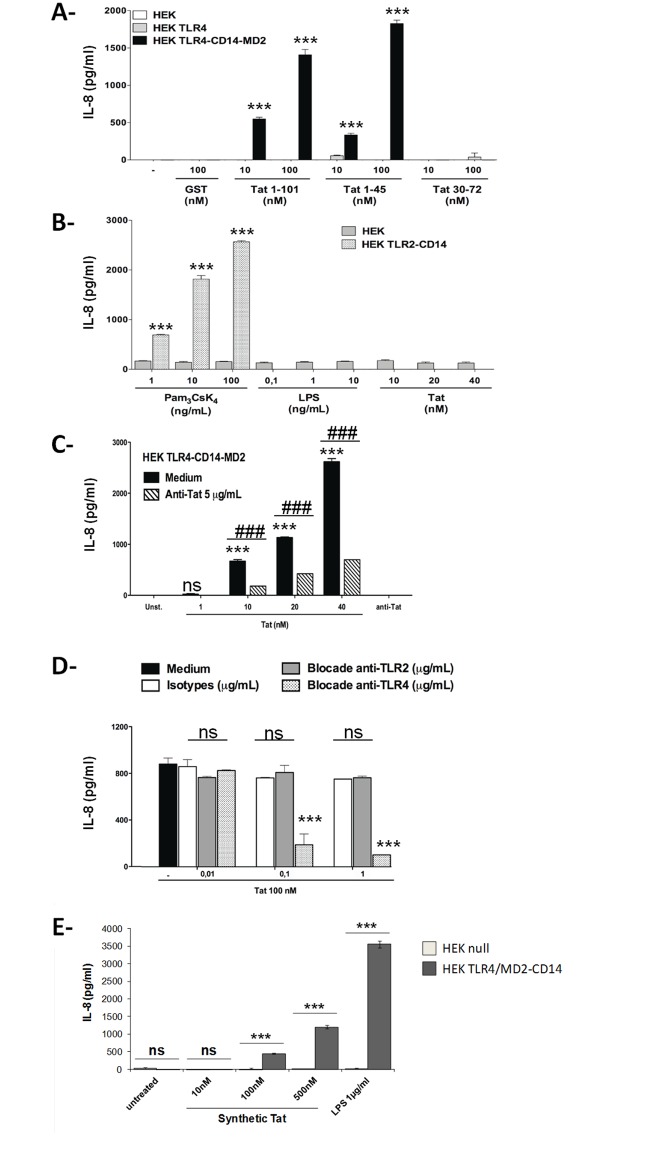
HIV-1 Tat induces production of IL-8 production in a TLR4-CD14-MD2 dependent manner.(A) HEK cell lines expressing TLR4 (grey histograms), TLR4-CD14-MD2 (black histograms), or HEK null, carrying an empty plasmid (white histograms) were pretreated or not with 10 and 100 nM of GST-Tat 1–101 or its deleted mutants 1–45 or 30–72. After 24 hrs., culture supernatants were recovered and IL-8 production was measured by ELISA. The data represent means +/- SD of three independent experiments. (B) HEK Null or HEK cell expressing TLR2-CD14 were pretreated or not with indicated amounts of GST-Tat 1–101 or LPS or Pam3CSK4. After 24h, IL-8 production in culture supernatant was analyzed by ELISA. The data represent means +/- SD of three independent experiments. (C) HEK-TLR4-CD14-MD2 cells were stimulated with Tat protein (Black histograms) or Tat protein previously incubated with 5 μg/mL of anti-Tat blocking antibodies (hatched histograms). After 24h of stimulation, IL-8 production induced by Tat was quantified in the culture supernatant by ELISA. The data represent means +/- SD of three independent experiments. (D) HEK-TLR4-CD14-MD2 cells were previously treated with increasing amounts of mAb anti-TLR4 or anti-TLR2 or isotypes control for 60 min before stimulation with Tat. After 24h, IL-8 production was measured in the culture supernatants by ELISA. The results are expressed in pg/ml. (E) HEK cell lines stably expressing TLR4/MD2-CD14 (HEK TLR4/MD2-CD14) or an empty plasmid (HEK Null) from InvivoGen were either kept untreated or treated with escalating doses of Synthetic Tat, or LPS as a positive control. After 24h of incubation, cell supernatant was collected and used for cytokine quantification by ELISA as described in Materials and Methods. The values are representative of at least three independent experiments. Statistical significance comparing "untreated" group versus "Treated (as indicated) " group are denoted with * for p < 0.05, ** p < 0.01, *** p < 0.001, ns non significant. Statistical significance comparing different group linked with a black line above the compared bar and are denoted with # for p < 0.05, ## p < 0.01, ### p < 0.001, ns non significant.